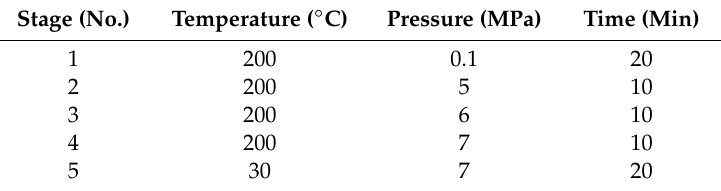
Table 4. Parameters used in the vacuum press during compression moulding of disk specimens. Stage